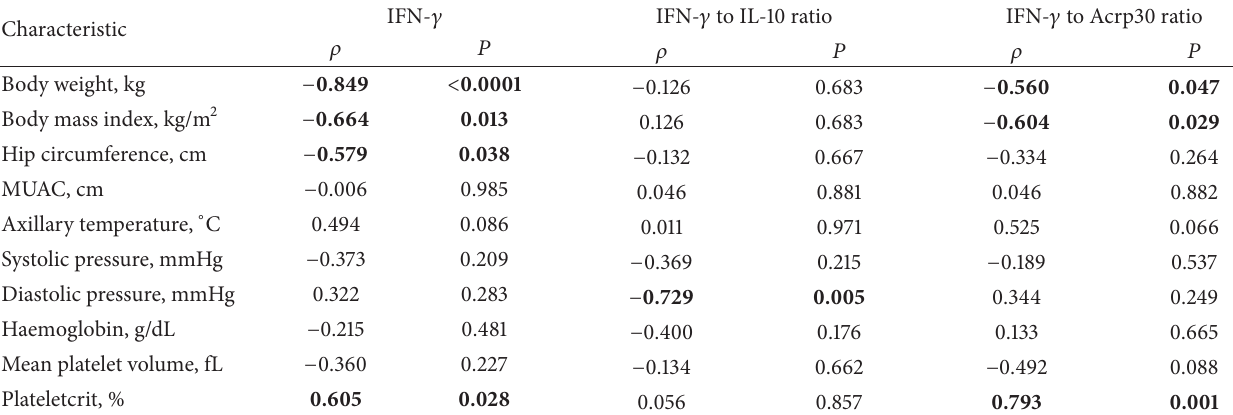
Table 2: Correlation of cytokines with physical and clinical measures.